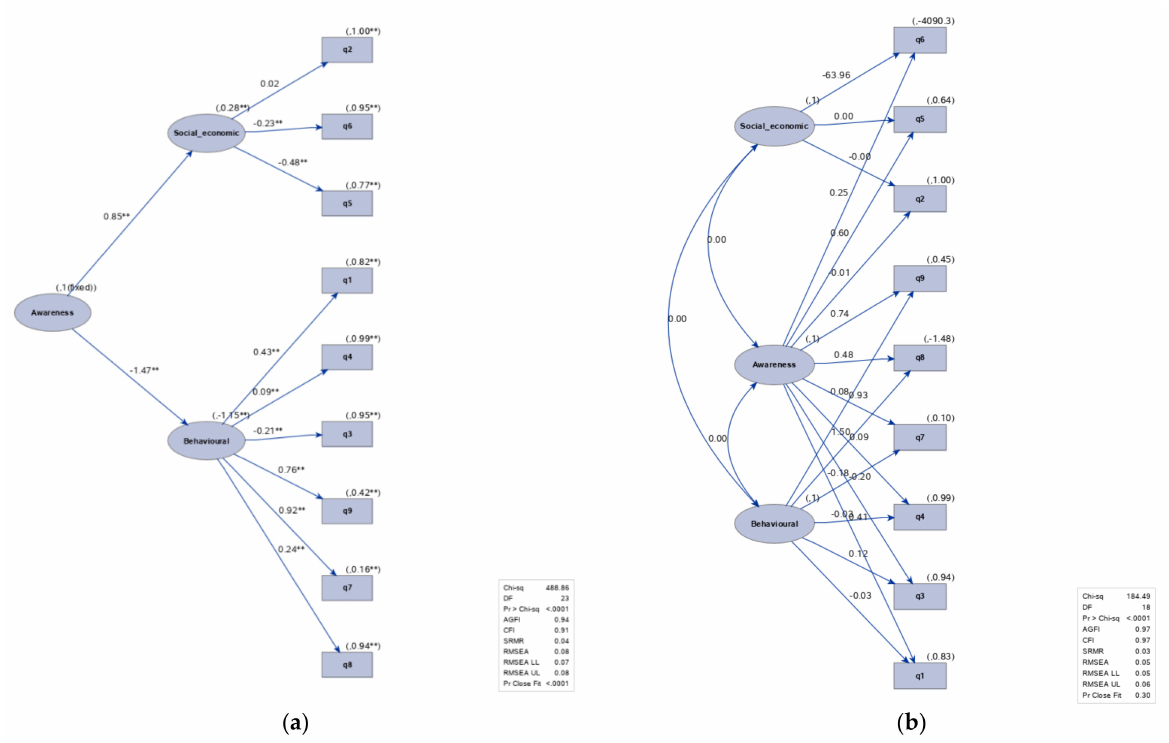
Figure 11. Path diagrams for the post-trial questionnaire data set ( a ) second-order, ( b )